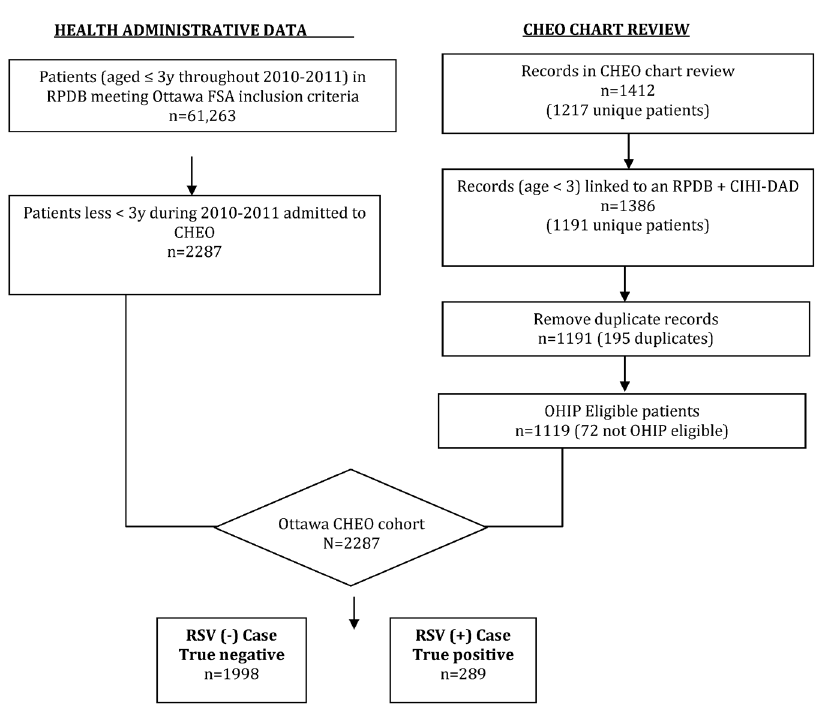
Fig 1. Flow diagram of reference standard cohort creation against which algorithms were validated. Abbreviations: CHEO = Children ’ s Hospital of Eastern Ontario; CIHI-DAD = Canadian Institute of Health